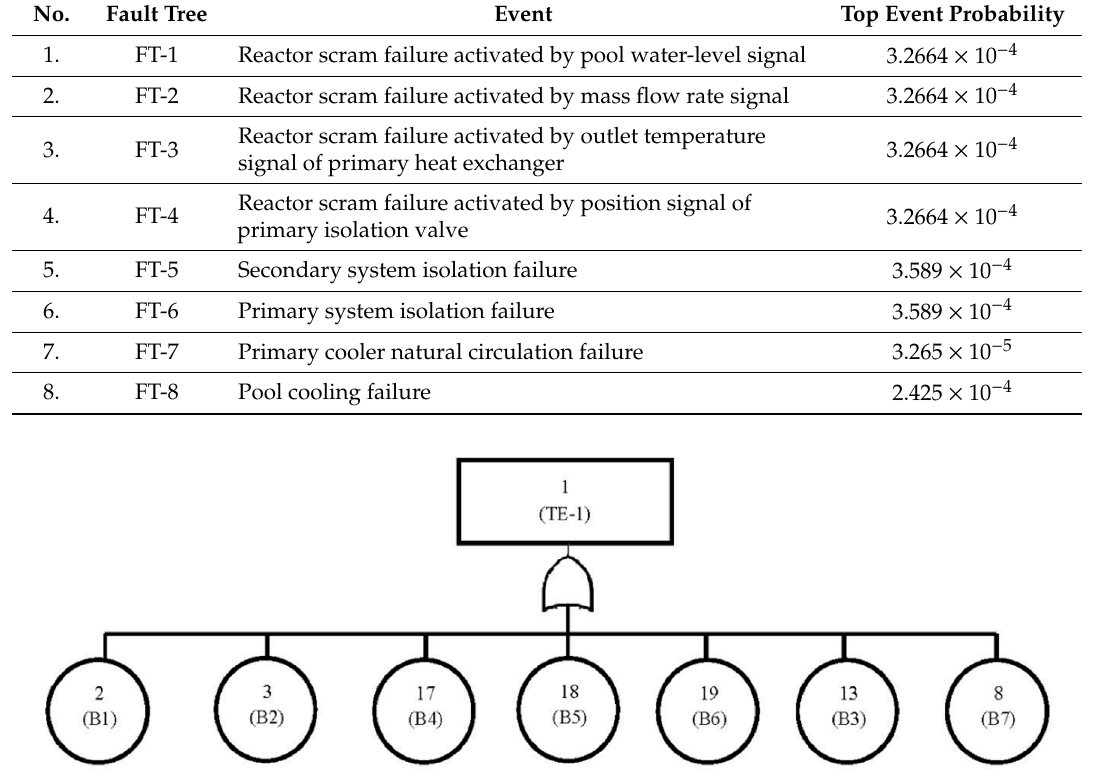
Figure 5. Simplified of